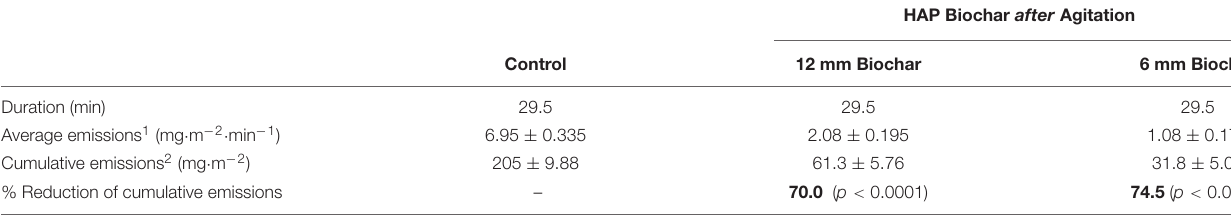
TABLE 4 | Biochar (HAP) treatment: the average flux and cumulative NH 3 emission after agitation (bold font signifies statistical significance).